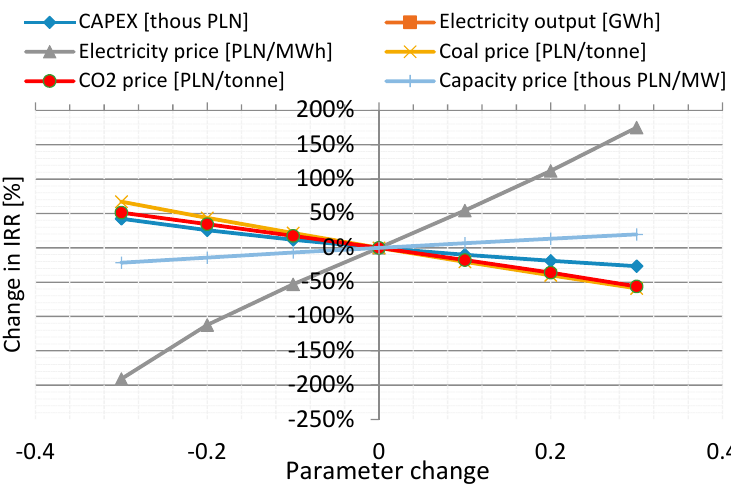
Figure 1. The sensitivity of the internal rate of return (IRR) to key coal-fired power project parameters in Poland.